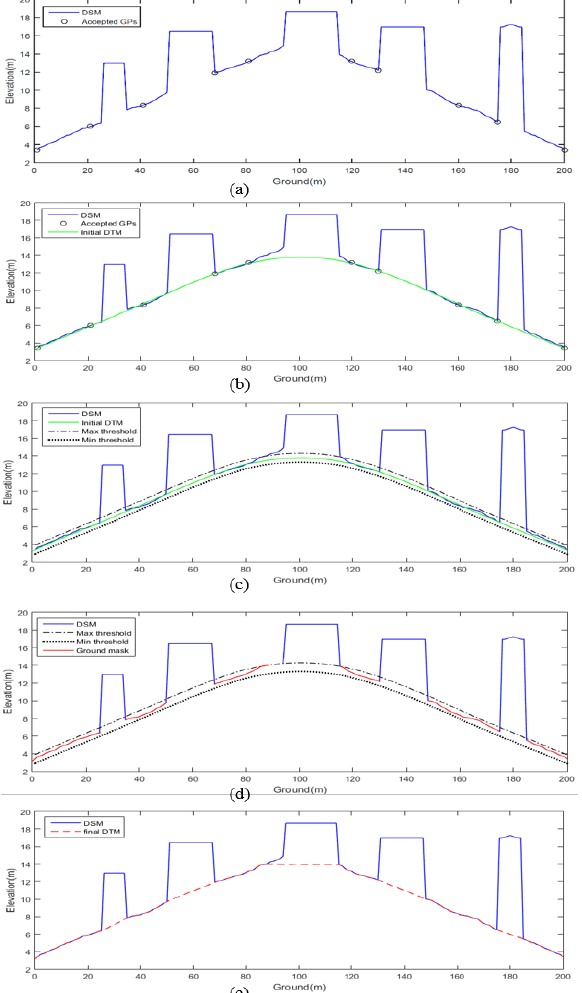
Figure (3). Logical steps of DTM generation by NGPs algorithm. Ground points (GPs) selected as minima on an